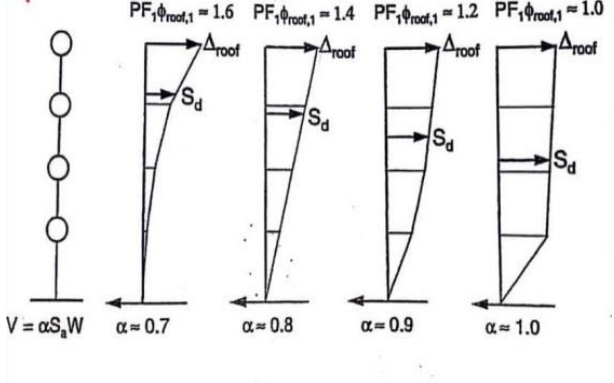
Fig. 2. Modal Participation Factors and Modal Mass